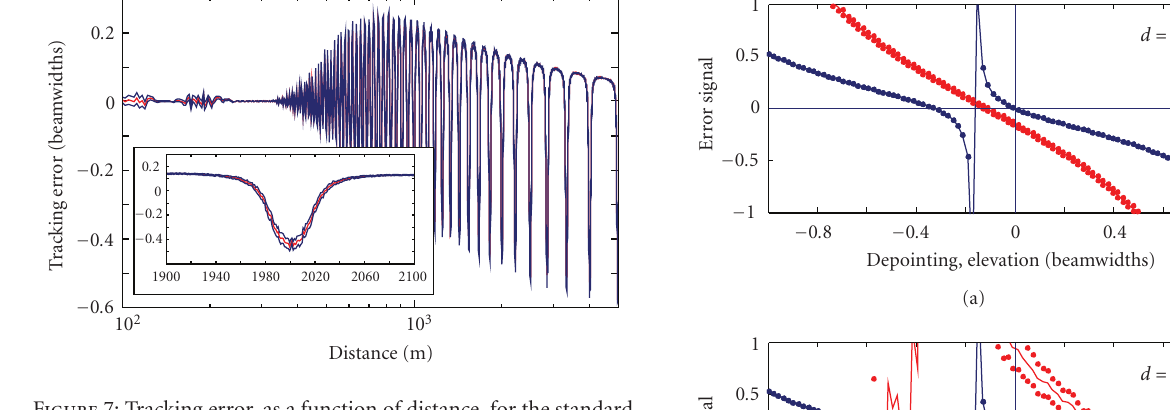
Figure 7: Tracking error, as a function of distance, for the standard monopulse over a rough sea. Red line: average value; blue lines: average plus or minus the standard deviation. In the inset a zoom over a small distance range.